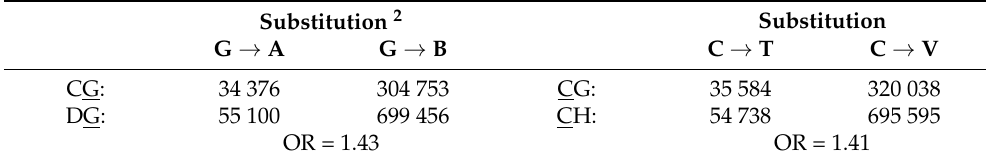
Table 1. A comparison of the rate of C → T substitution within CG dinucleotides 1 to the C → T rate in other contexts.